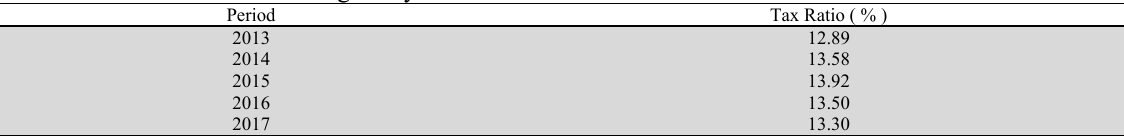
Indonesian Tax Ratio level during five years